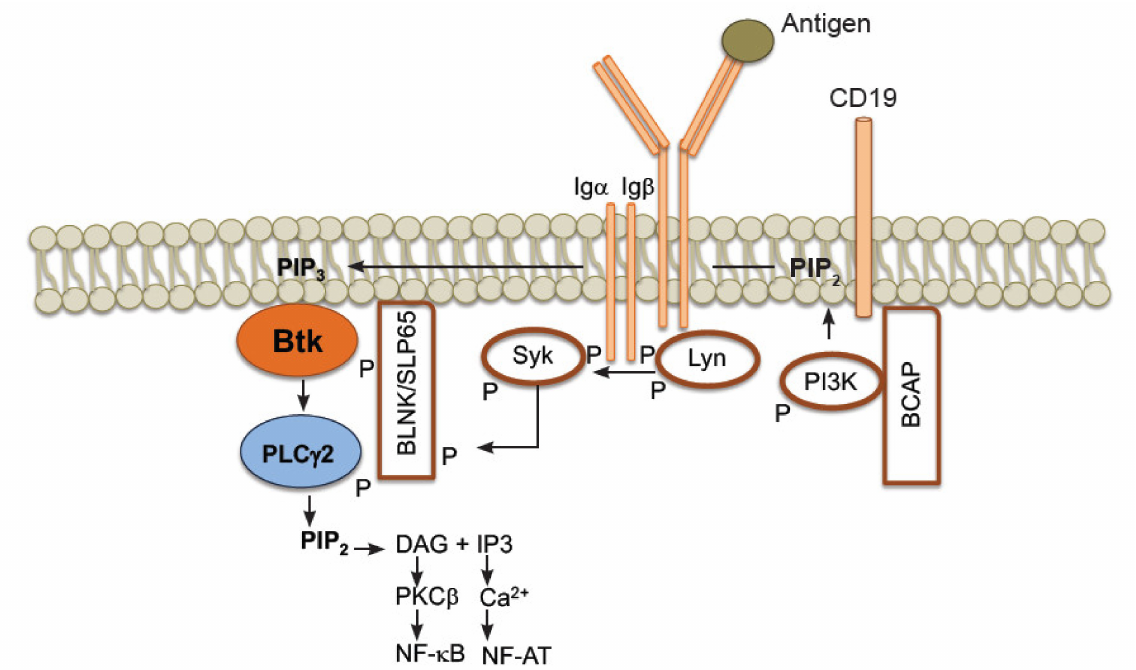
Figure 2. Schematic representation of role of BTK in signaling after antigen binding to the B cell receptor (BCR). Antigen bind- ing triggers a cascade of signaling events, which leads to BTK translocation from the cytosol to the cell membrane through their union to phosphatidylinositol (3,4,5)-trisphosphate (PIP 3 ). BTK phosphorylates phospholipase C gamma 2 (PLC γ 2), cleaves phosphatidylinositol 4,5-bisphosphate (PIP2), and generates two second messengers: inositol 1,4,5-triphosphate (IP3) and diacylglycerol (DAG). This activates pathways, leading to the nuclear factor of activated T cells (NFAT) and nuclear factor kappa B (NFkB). (Figure taken from Rom á n-Garc í a [43], with